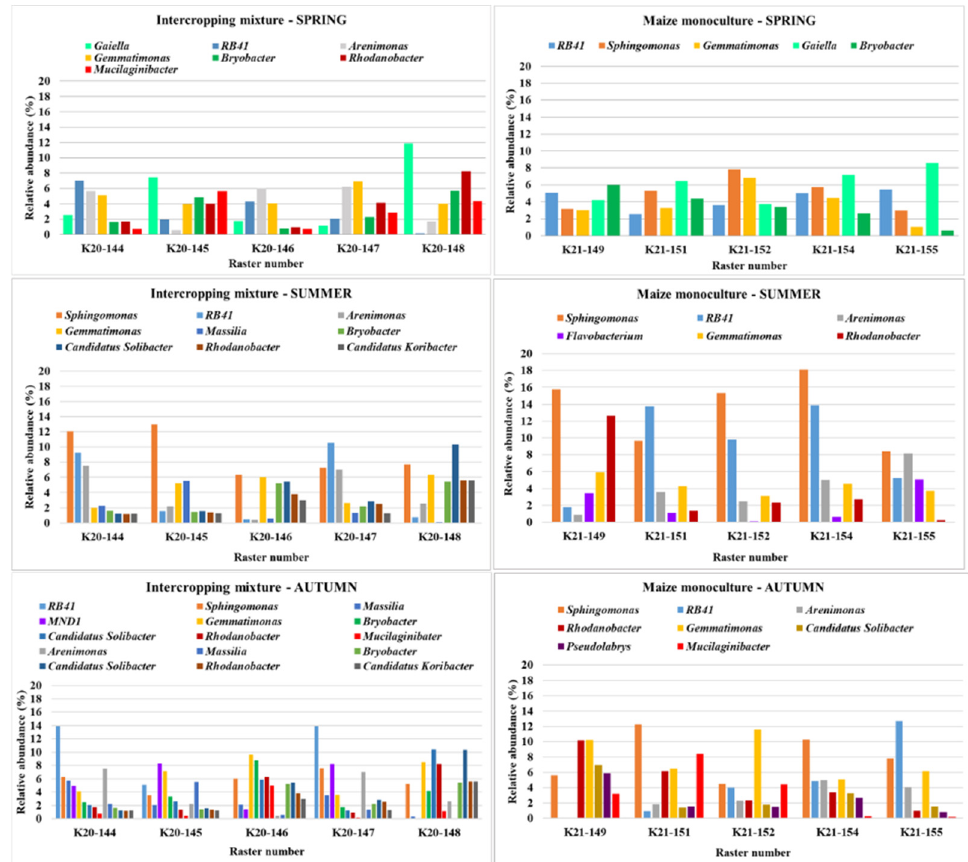
Figure 5. Dominant bacterial genera in the rasters of field K20 under the intercropping mixture and field K21 under the maize monoculture in spring, summer, and autumn.